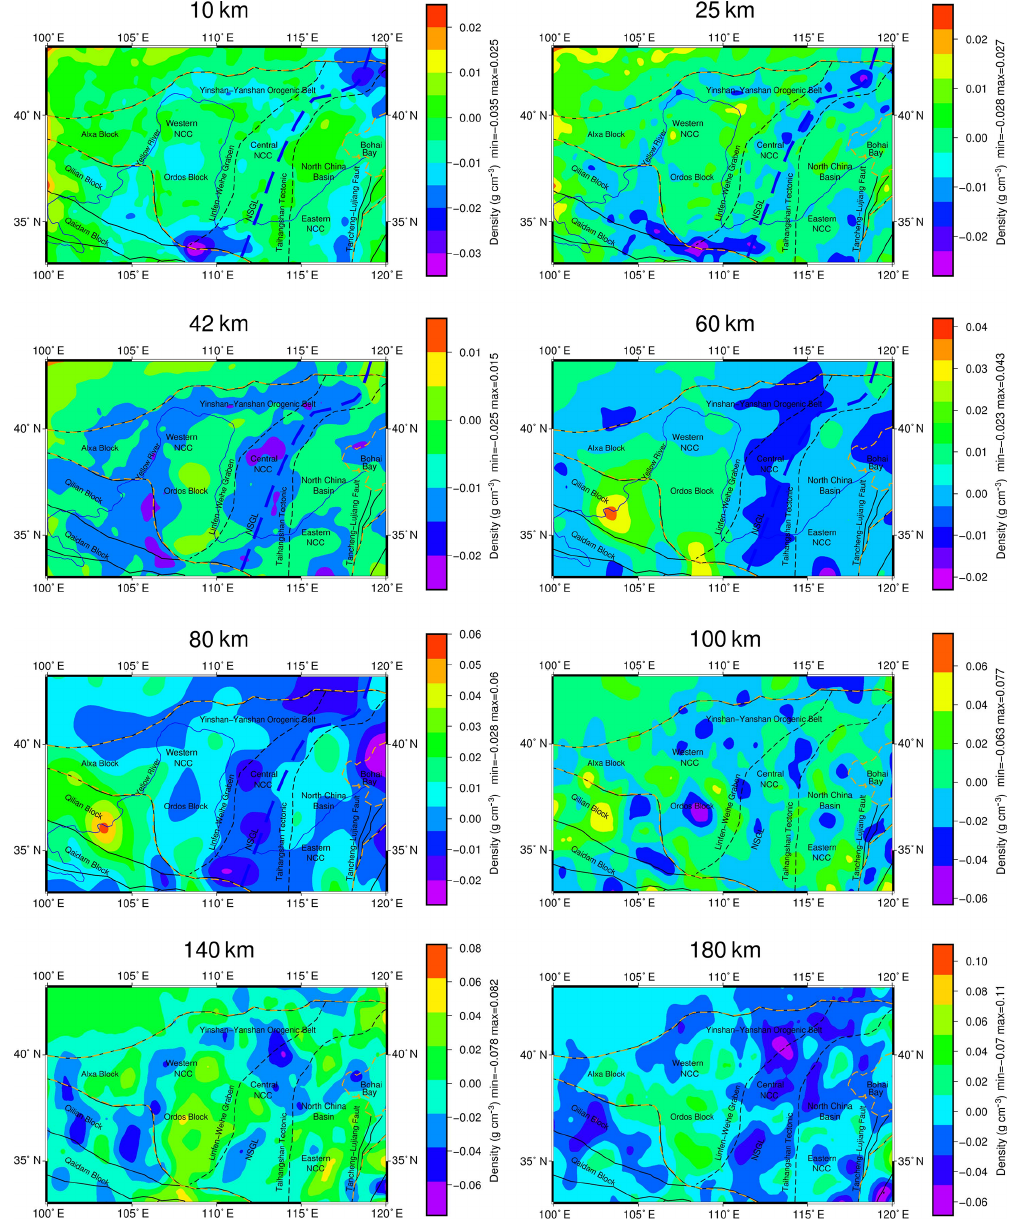
Figure 6. Lithospheric density distribution of the NCC based on gravity values at different